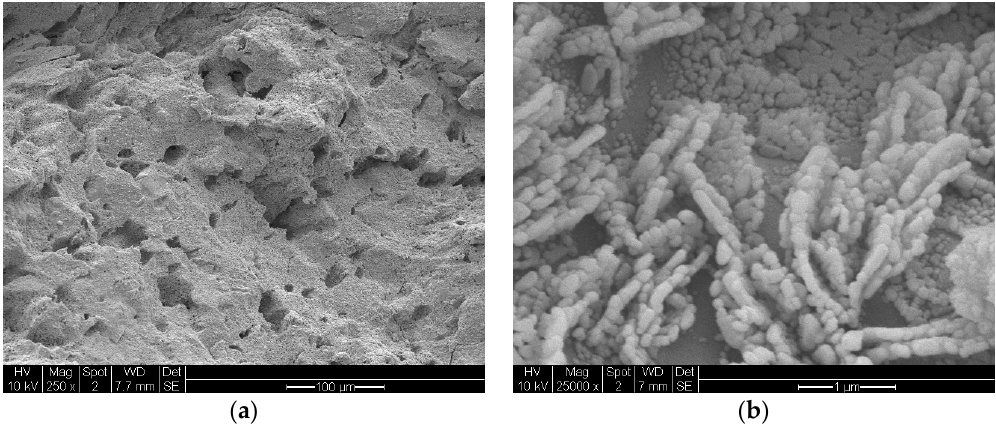
Figure 17. Scanning electron microscopy of sample Co/Si = 1/5 (using silane coated silica and processed using the Haake Mixer, Section 3.4, followed by heat treatment at 600 ˝ C using Method-C; (Section 3.8) at two magnifications). ( a ) Scale bar = 100 µ m; ( b ) Scale bar = 1 µ m.